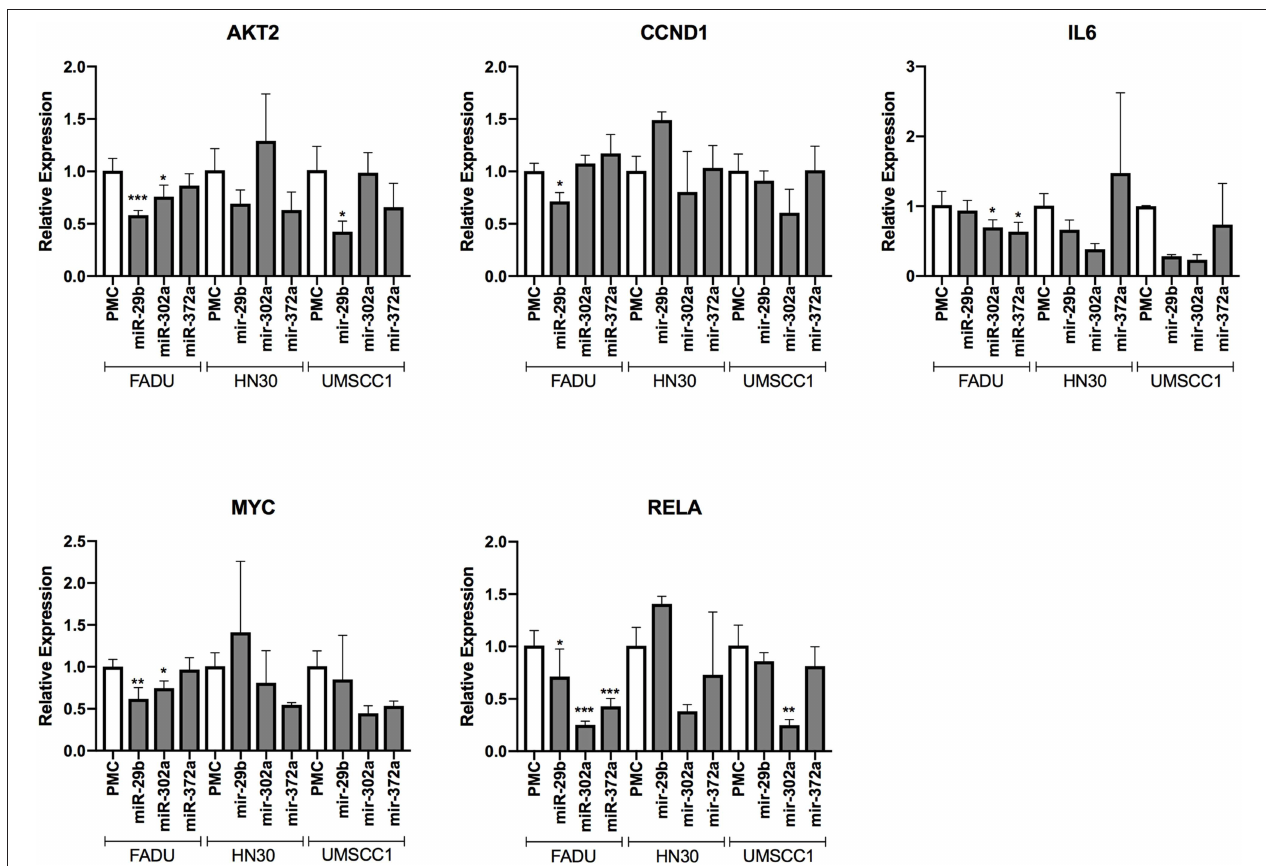
FIGURE 7 | Changes in the transcript levels of direct and indirect targets of anti-survival/EMT miR group following miR transfection. The cell lines FADU, HN30, and UMSCC1 were transfected with PMC (control) or miR mimics from G2 (miR-29b-3p, miR-302a-3p, and miR-372), followed by TNF- α stimulation (20ng/mL) for 48h and qPCR with primers for AKT2 , CCND1 (cyclin D1), IL6 , MYC, and RELA . Alterations in relative gene expression levels, relative to cells transfected with miR-CTR (PMC). Statistically significant differences ( t -test), in comparison to the reference control group (PMC): * p < 0.05; ** p < 0.01; *** p <